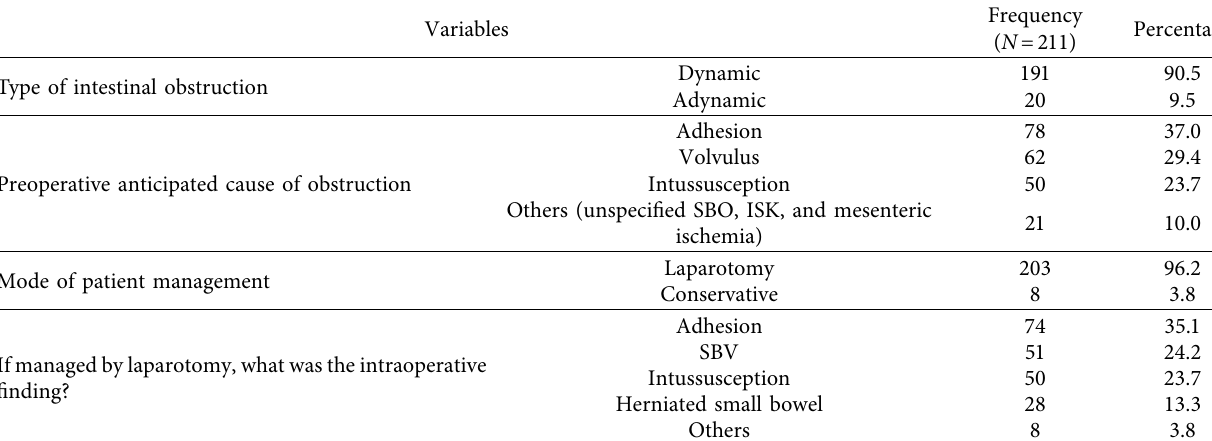
Table 2: Causes and management approaches of patients managed for small bowel obstruction in Nekemte Referral Hospital from January 1, 2014, to December 30,